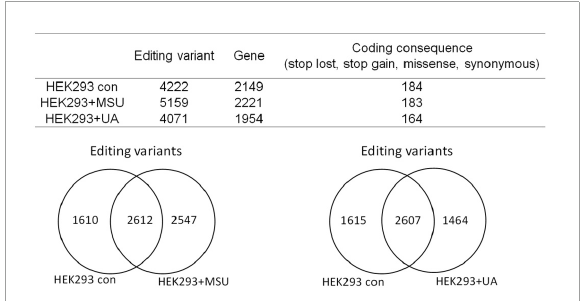
FIGURE6 Genome-wide analysis of RNA editing in MSU- or UA-treated HEK293 cells The upper panel displays the numbers of variants and genes with RNA editing in mock, MSU-treated, or US-treated HEK293 cells. The numbers of variants in a coding sequence were further analyzed. RNA editing affected the coding sequence, including gain of stop codon, loss of stop codon, missense mutations, and non-synonymous mutations. The left lower panel presents the common variants and unique variants in untreated and MSU-treated HEK293 cells, and the right lower panel displays the common variants and unique variants in untreated and UA-treated HEK293